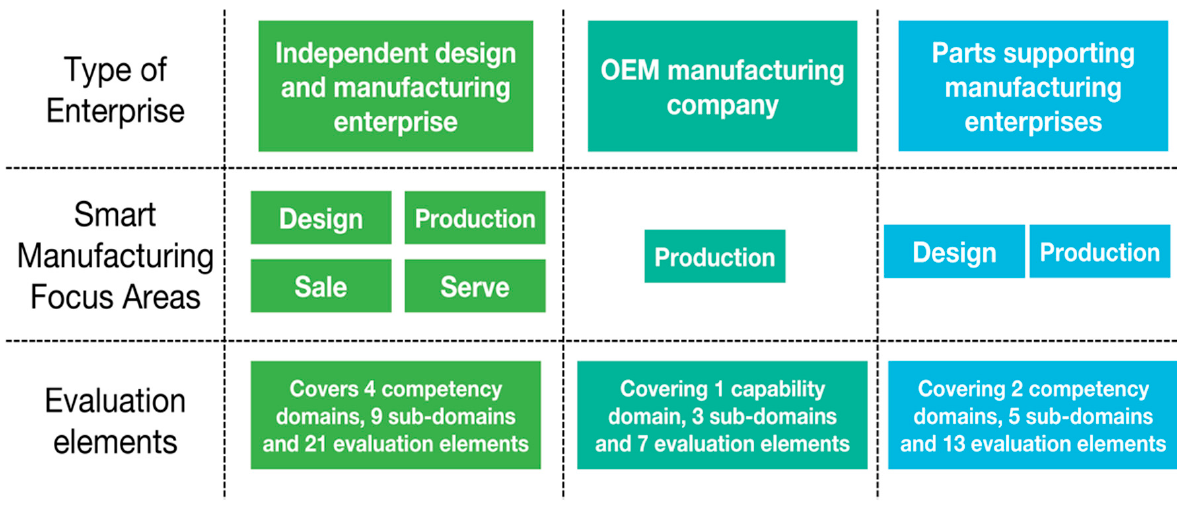
Figure 3. Focus areas of intelligent manufacturing of different types of chair industry enterprises.